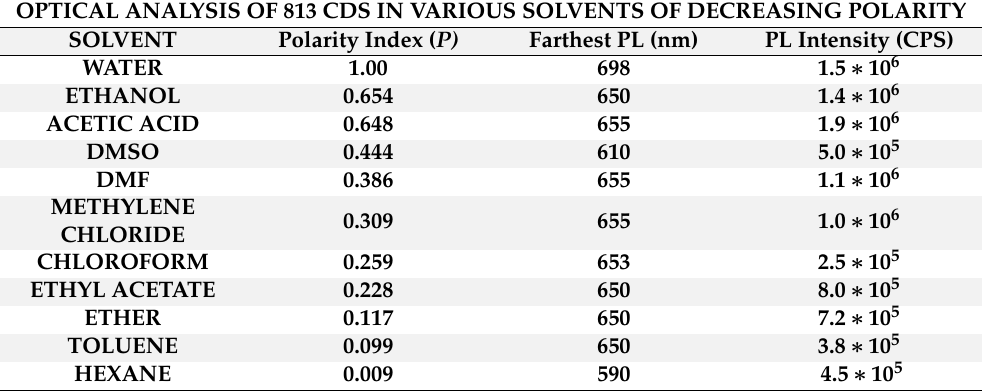
Table 1. Optical data of 813-CDs (farthest PL and intensity) and solvents used with their respective polarity